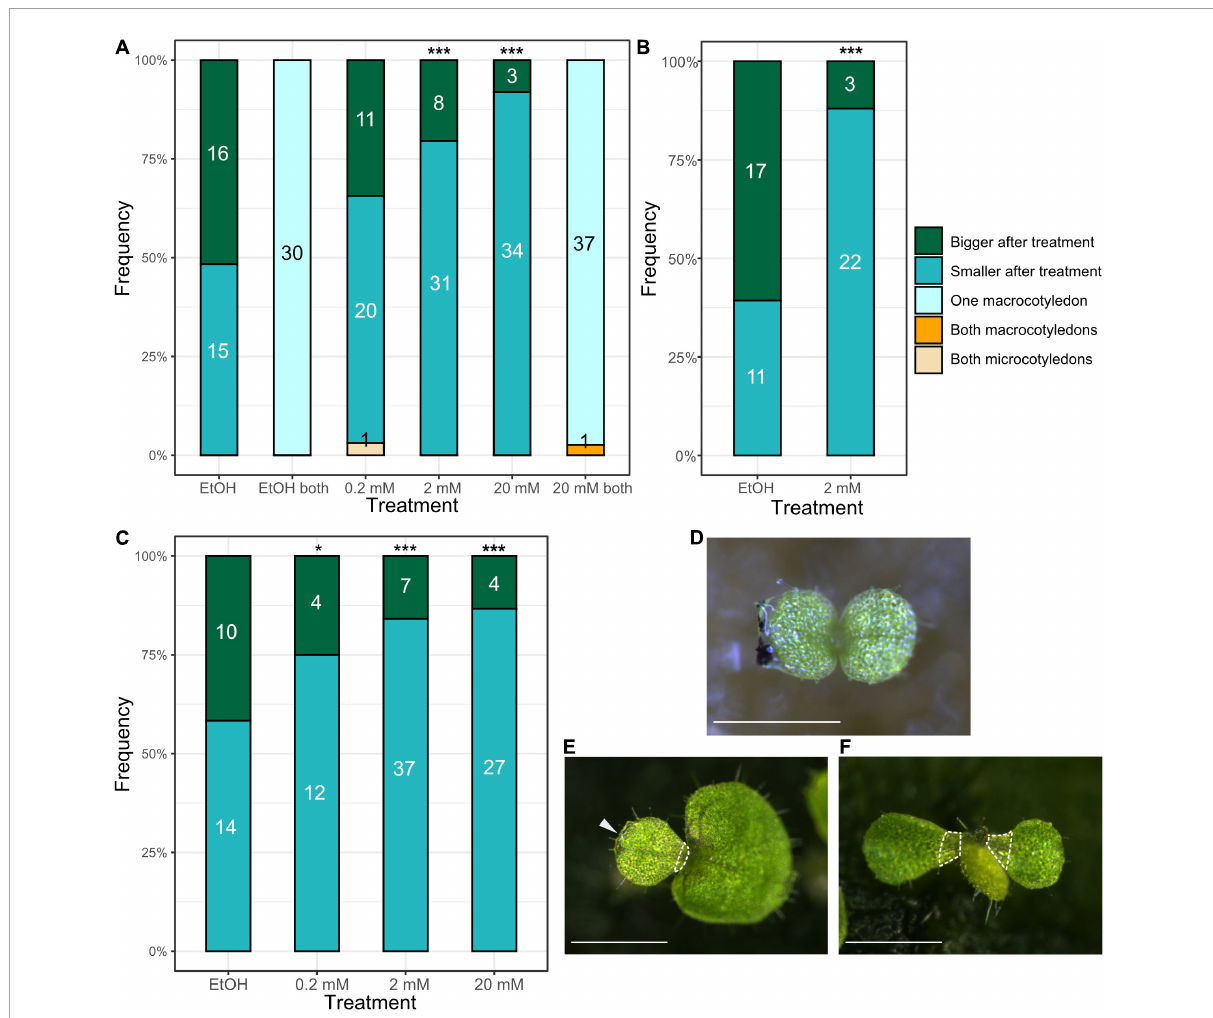
FIGURE2 Auxin treatment of cotyledons in the isocotylous stage reveals that a higher concentration in one of the cotyledons induces the microcotyledon fate. (A–C) The results of three independent auxin application experiments. “Bigger after treatment” and “Smaller after treatment” indicate individuals in which the cotyledon treated with the lanolin paste grew larger (macrocotyledon) and those that stopped growth (microcotyledon) after treatment, respectively. “One macrocotyledon” indicates that one of the cotyledons differentiated into a macrocotyledon and the other differentiated into a microcotyledon. “Both macrocotyledons” and “Both microcotyledons” indicate individuals that harbored two macrocotyledons and two microcotyledons, respectively. The numbers in the bars indicate the absolute number of individuals in each category. The x-axis shows the types of treatment: “EtOH” indicates the treatment with lanolin only containing ethanol, used to dilute IAAK. “0.2 mM,” “2 mM,” and “20 mM” indicate the concentration of auxin dissolved in the lanolin in the treatment. On the x axis, “both” indicates that the lanolin was applied to both of the cotyledons. (D) The stage at which the lanolin treatment was conducted. Lanolin was applied to the edge of the individual cotyledon, and black carbon particles were stuck on the lanolin to make it easier to show the position of the lanolin. (E) One of the individuals treated with 20 mM IAAK, observed in experiment (A) . The arrow indicates the lanolin, which can be seen on the cotyledon on the left (microcotyledon). The hatched white line shows narrower part in the microcotyledon lamina. (F) The individual harboring both microcotyledons in experiment (A) . A new organ was produced between the two cotyledons. The hatched white line shows narrower part in the microcotyledon lamina. * p < 0.05, *** p < 0.001 in a binomial test of “Bigger after treatment” and “Smaller after treatment” (The number of occurrences of “Both macrocotyledons” and “Both microcotyledons” is not included because they are very rare). Bar = 0.5 mm in (D) and 1 mm in (E,F)